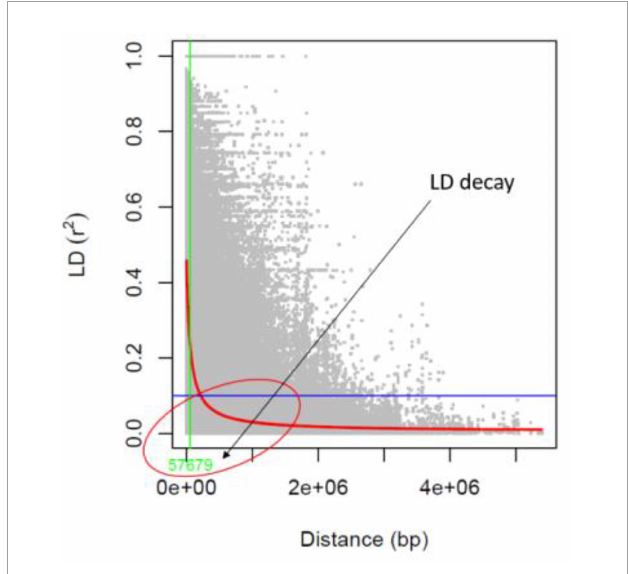
FIGURE5 Linkage disequilibrium (LD) decay value (bp) in the association mapping